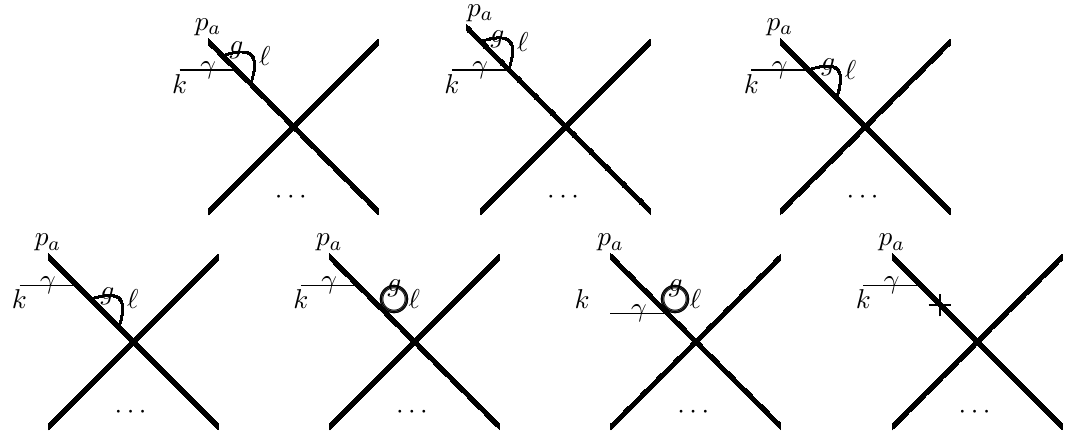
Figure 23 . Diagrams in which the external photon and both ends of the internal graviton attach to the same scalar leg.